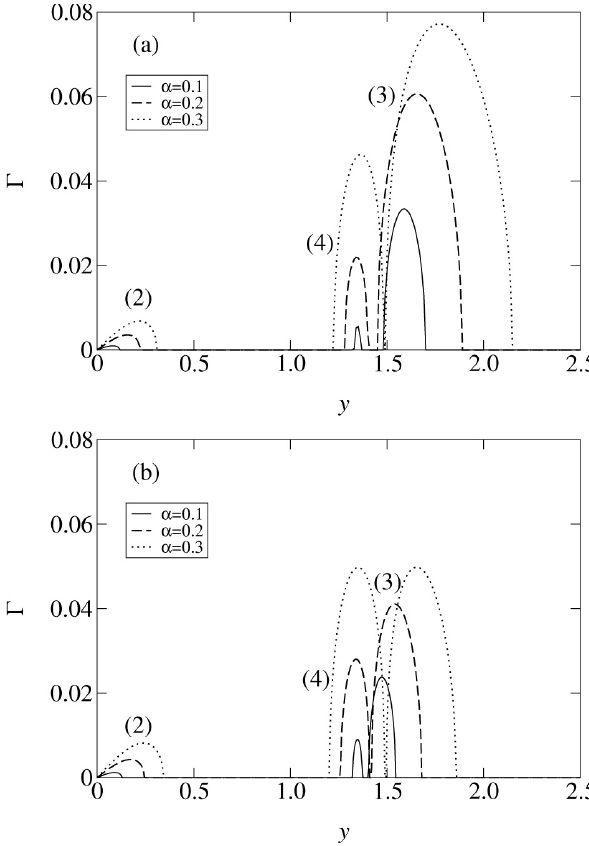
Fig. 14. Maximum growth rate vs. pump wave amplitude α . Nu- merical labels for crossings are taken from Fig. 12. (a) Crossing (3), ( S + , p − ). (b) Crossing (5), ( e − , p − ).